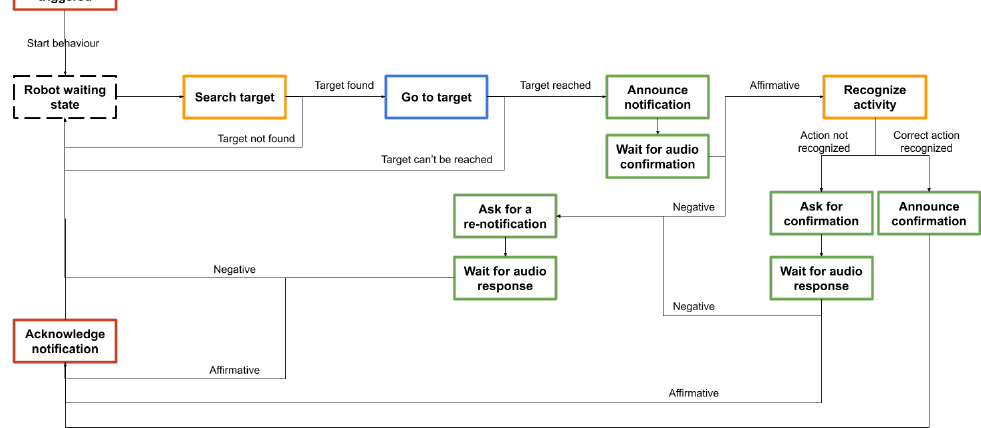
Figure 16. Interaction between tasks in the proposed scenario. Color coding relates to functionality modules involved in the realization of the behavior: orange—Vision module, blue—Navigation module, green—Dialogue module, and red—Behavior Composition